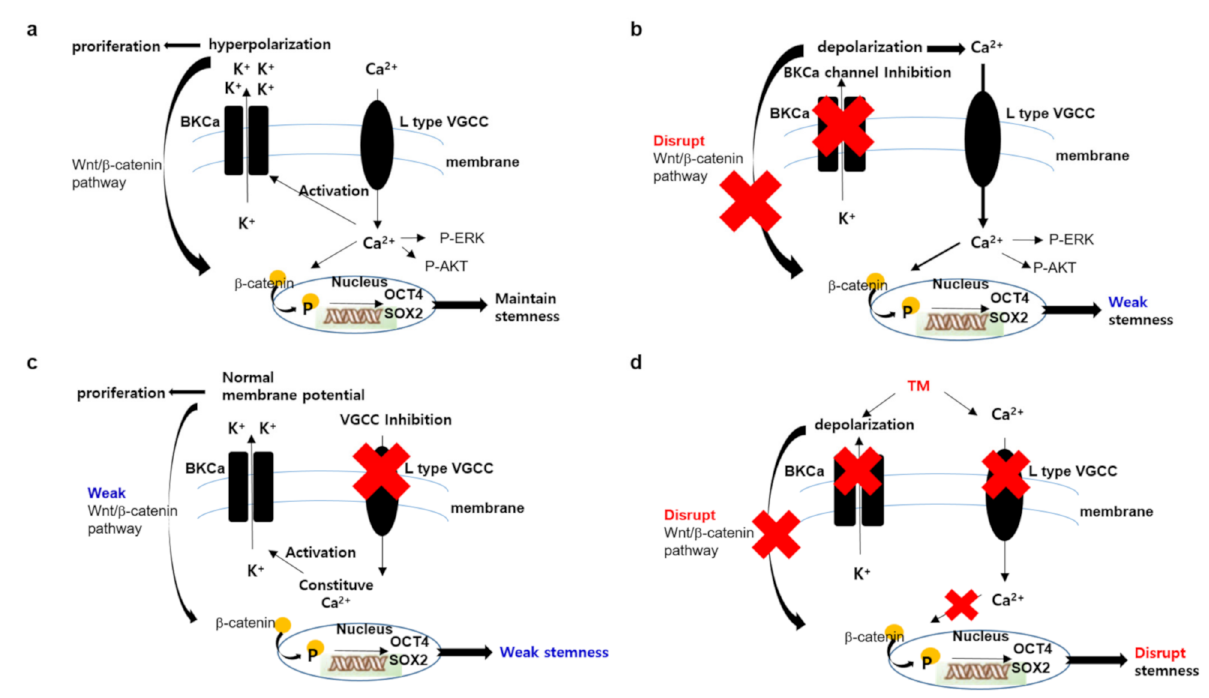
Figure 5. Proposed mechanism of TM in ovarian CSCs. ( a ) In ovarian CSCs environment, the amplified Ca 2+ channel functions to maintain stemmness and cell proliferation through the AKT, ERK or Wnt pathway. The amplified BKCa channel functions to further activate the wnt/ β -catenin pathway through hyperpolarized membrane potential. ( b ) When the BKCa channel is inhibited by selective inhibitor, such as paxillin, the Ca 2+ channel is further activated by positive feedback following membrane depolarization. Increasing of intracellular Ca 2+ concentration is enough to maintain stemness and proliferation. ( c ) When the Ca 2+ channel is inhibited by a selective inhibitor, such as manidipine, the BKCa channel activity enables the maintenance of a weak stemness and, therefore, requires a stronger Ca 2+ channel blockade to induce cell death. ( d ) When the Ca 2+ channel and BKCa channel are blocked simultaneously by TM, though weakly, it is enough to disrupt stemness and induce cell death.